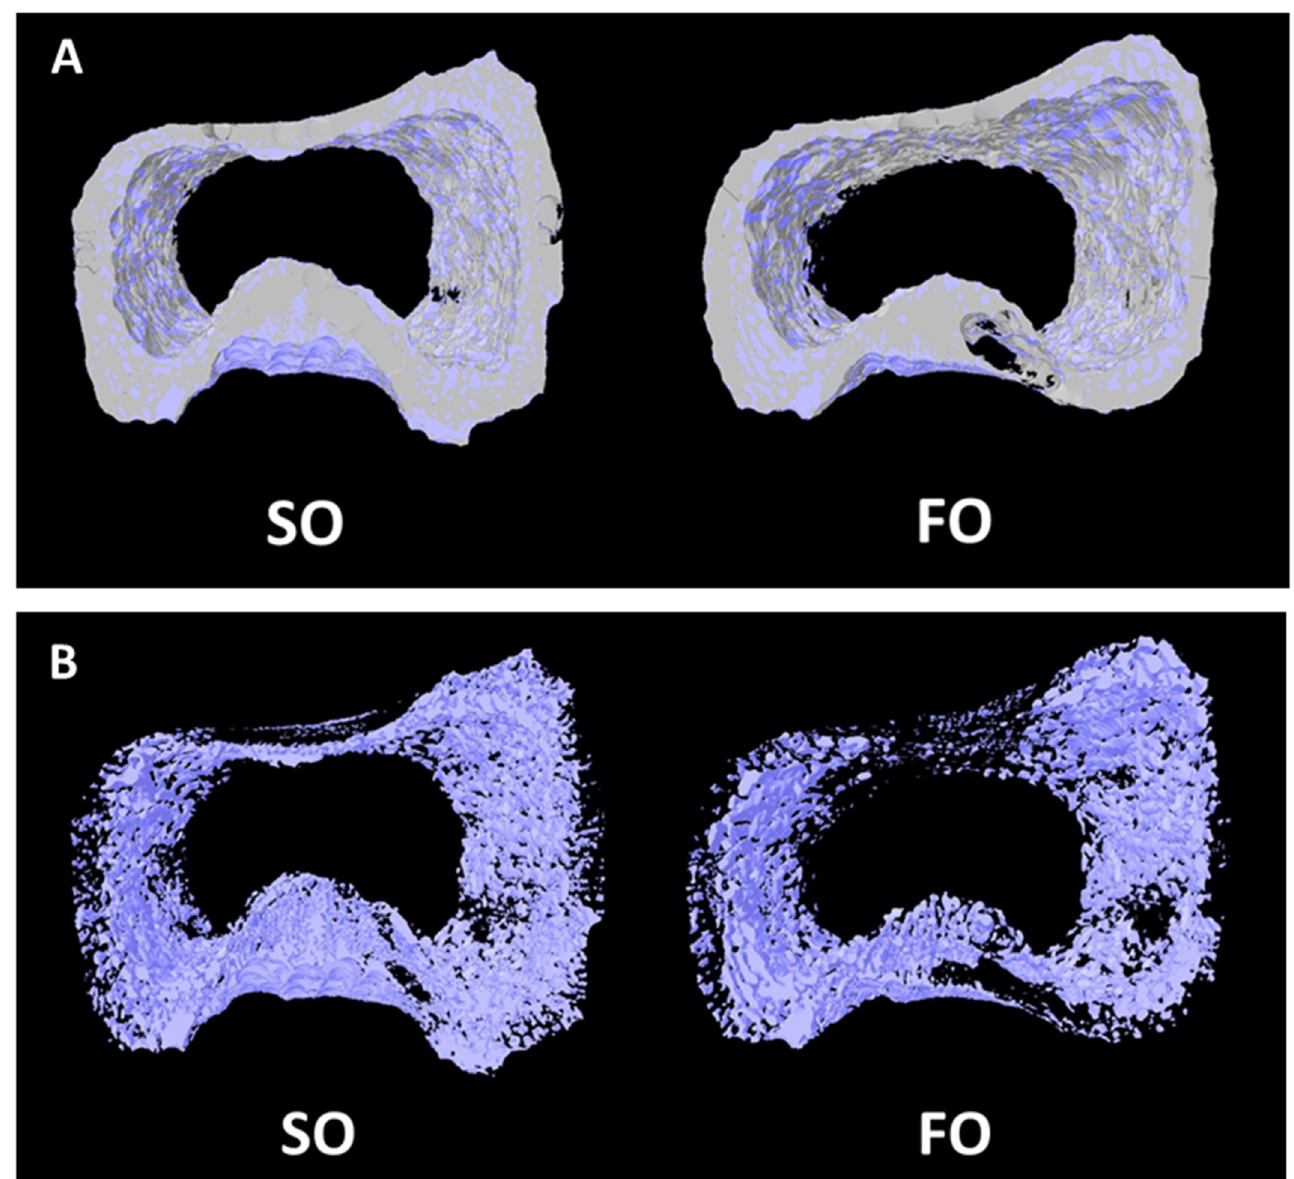
Fig 1. Representative reconstructed 2D images of market-age-broiler femur metaphysis (42 days of age). (A) reconstructed images of cortical porosity (purple) within the cortical bone; (B) lateral view of the reconstructed cortical porosity extracted from bone, indicated the cortical bone pore size, pore volume and porosity